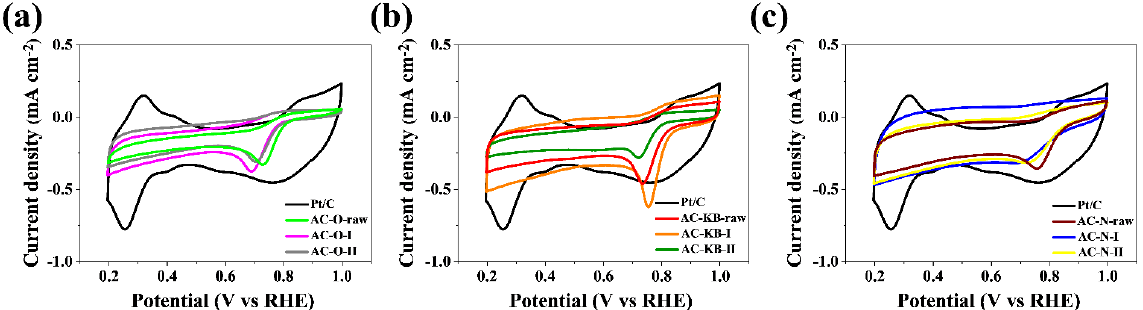
Figure 8. CV curves of the ( a ) AC–O; ( b ) AC–KB; ( c ) AC–N compared with Pt/C catalysts in an O 2 -saturated 0.1 M KOH solution.